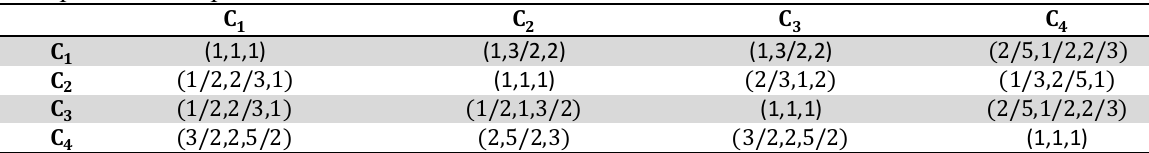
The pairwise comparison matrix for